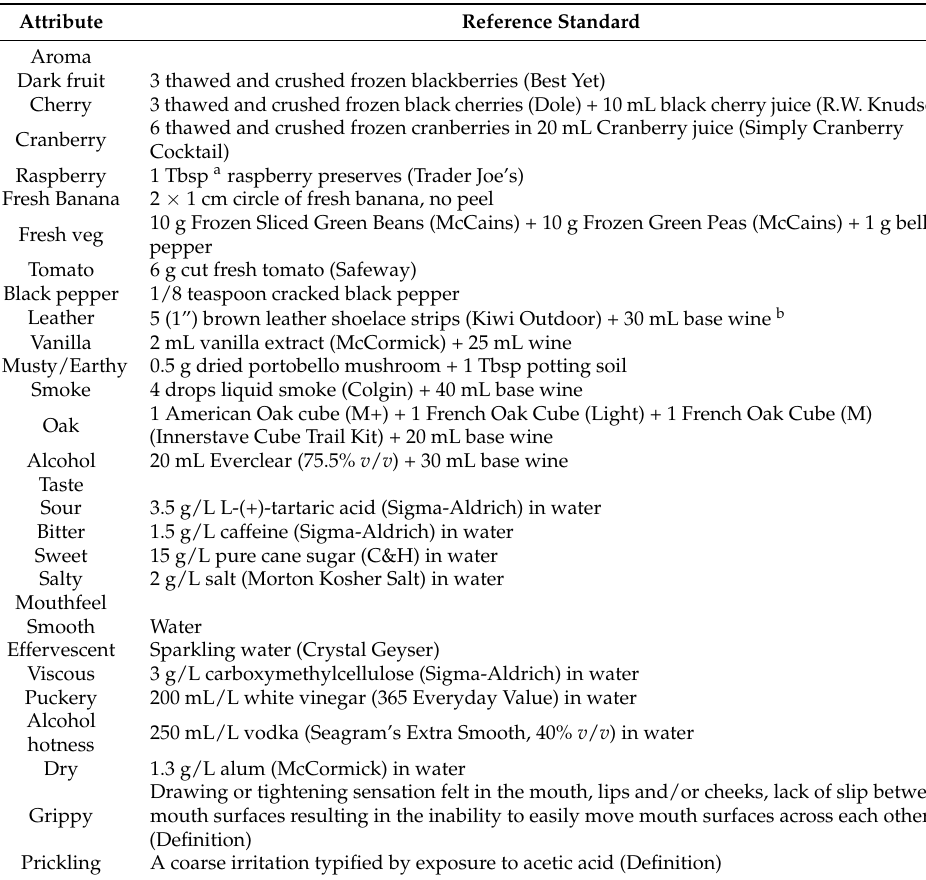
Table 2. Attributes and corresponding reference standards for the Barbera descriptive analysis panel.